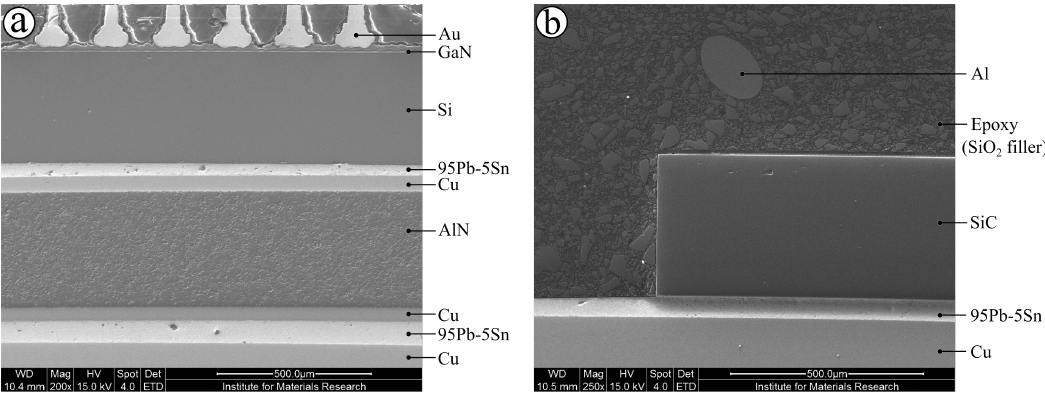
Figure 7. Scanning electron microscopy cross section images of ( a ) a cascode GaN device and ( b ) a SiC device with the respective material